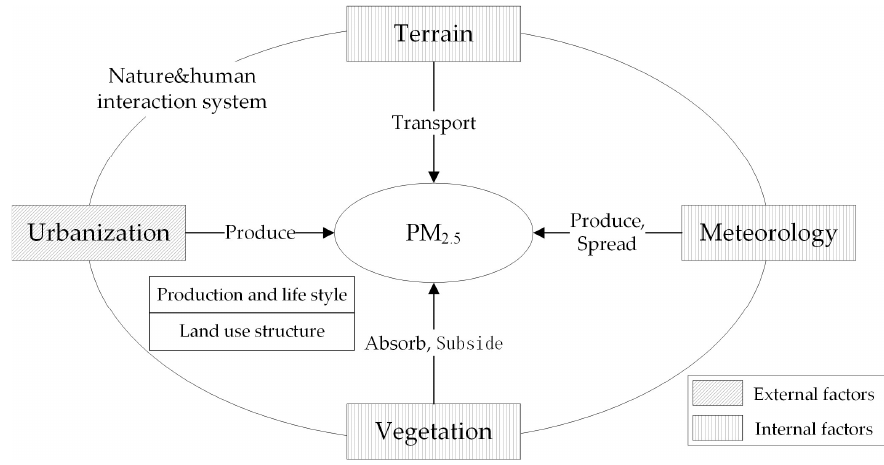
Figure 5. Effect of PM 2.5 concentration.